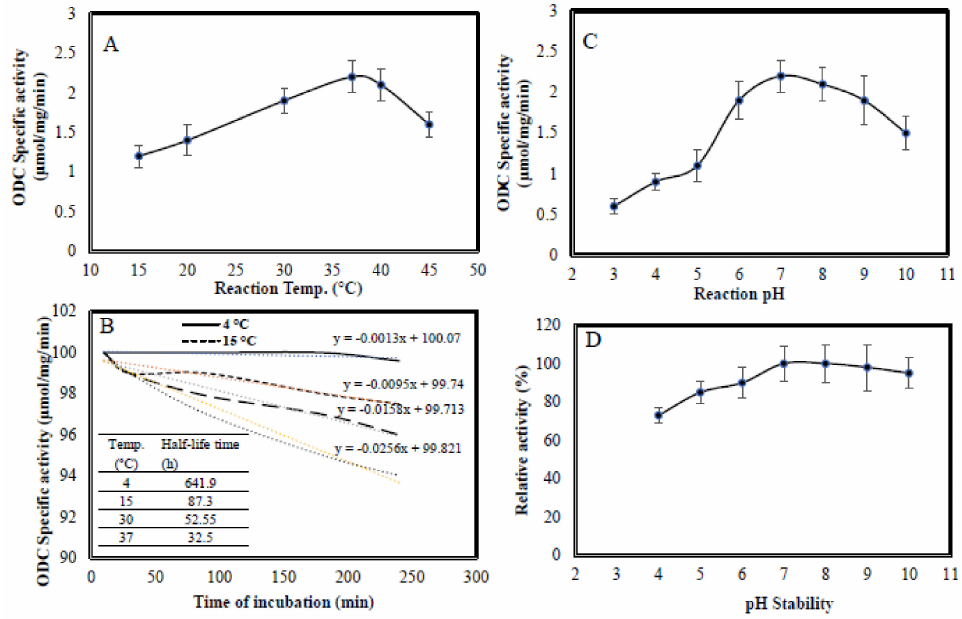
Figure 4. Biochemical properties of ODC purified from A. terreus . Reaction temperature ( A ), thermal stability ( B ), reaction pH ( C ) and pH stability ( D